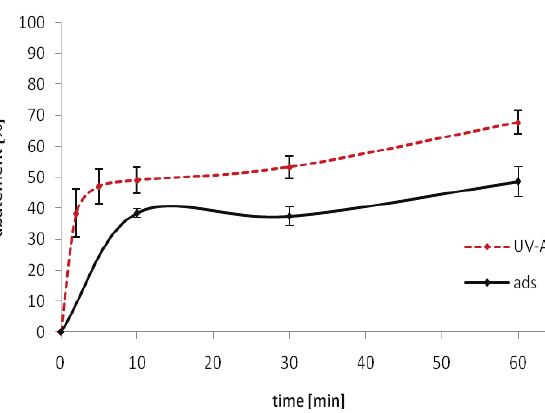
Figure 17. Photocatalytic assisted abatement of tetracycline under UV-A radiation by using zircon modified TiO ) above red curve, 2 2 photocatalysts Zr-TiO (upper red curve), contribution of 2 adsorption to the abatement (below black curve).